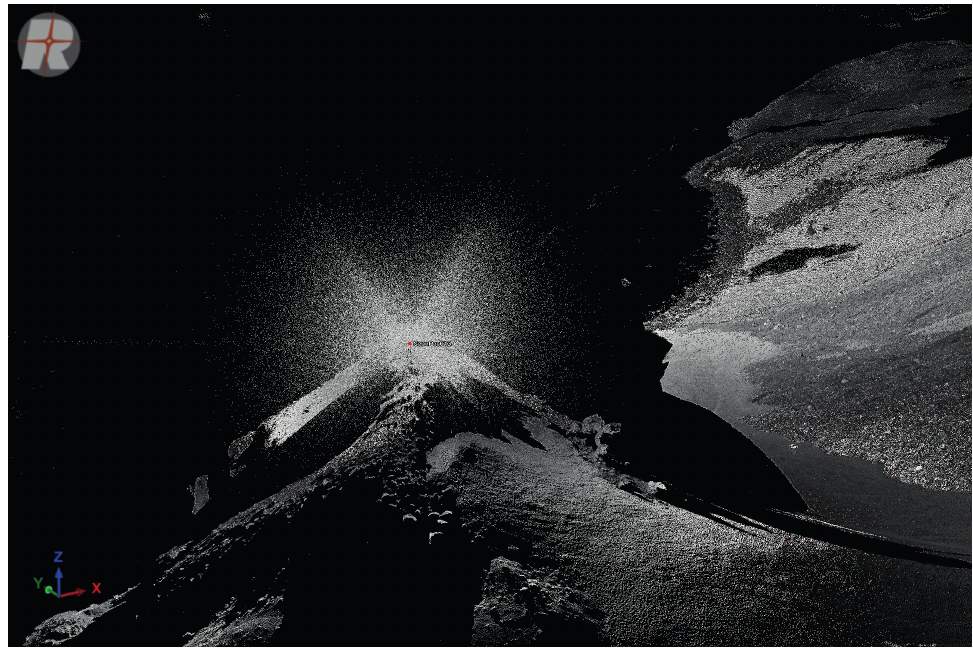
Figure 2 - Cloud with some points (airborne particles registered with high sensibility mode), to be extracted and filtered from the current terrain in the study